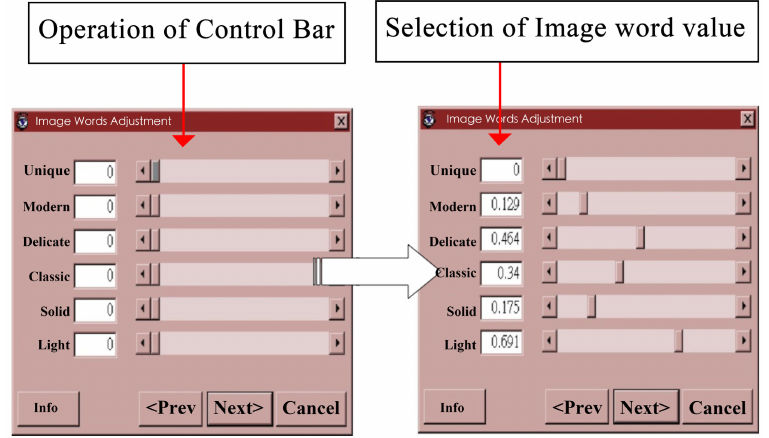
Figure 12. The footage of item-choosing motions in executing operation of automatic form design interface.